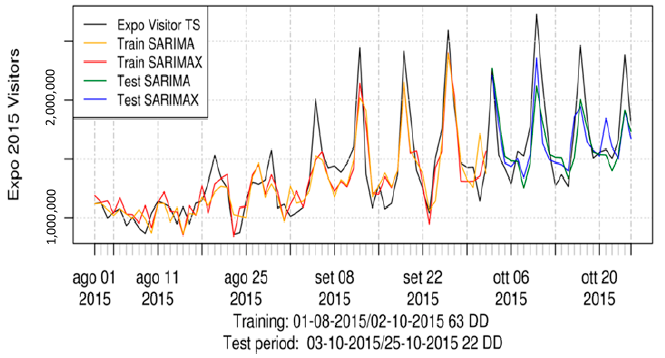
Figure 14. Twitter Vigilance predictive models for people attendance at EXPO 2015. The picture shows the comparison results among different models built on the collected Twitter Vigilance data and the real number of registered visitors.